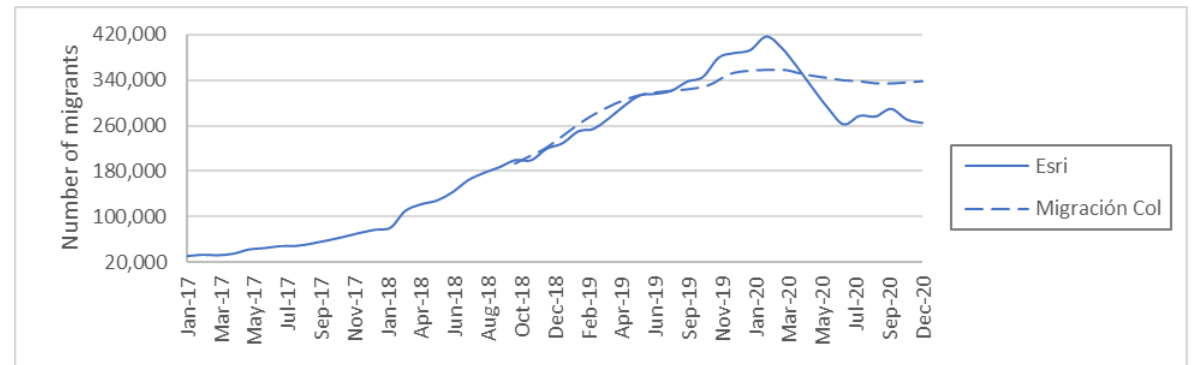
Figure 3. Comparison of Venezuelan migrants to Bogotá as reported by Esri vs Migración Colombia.